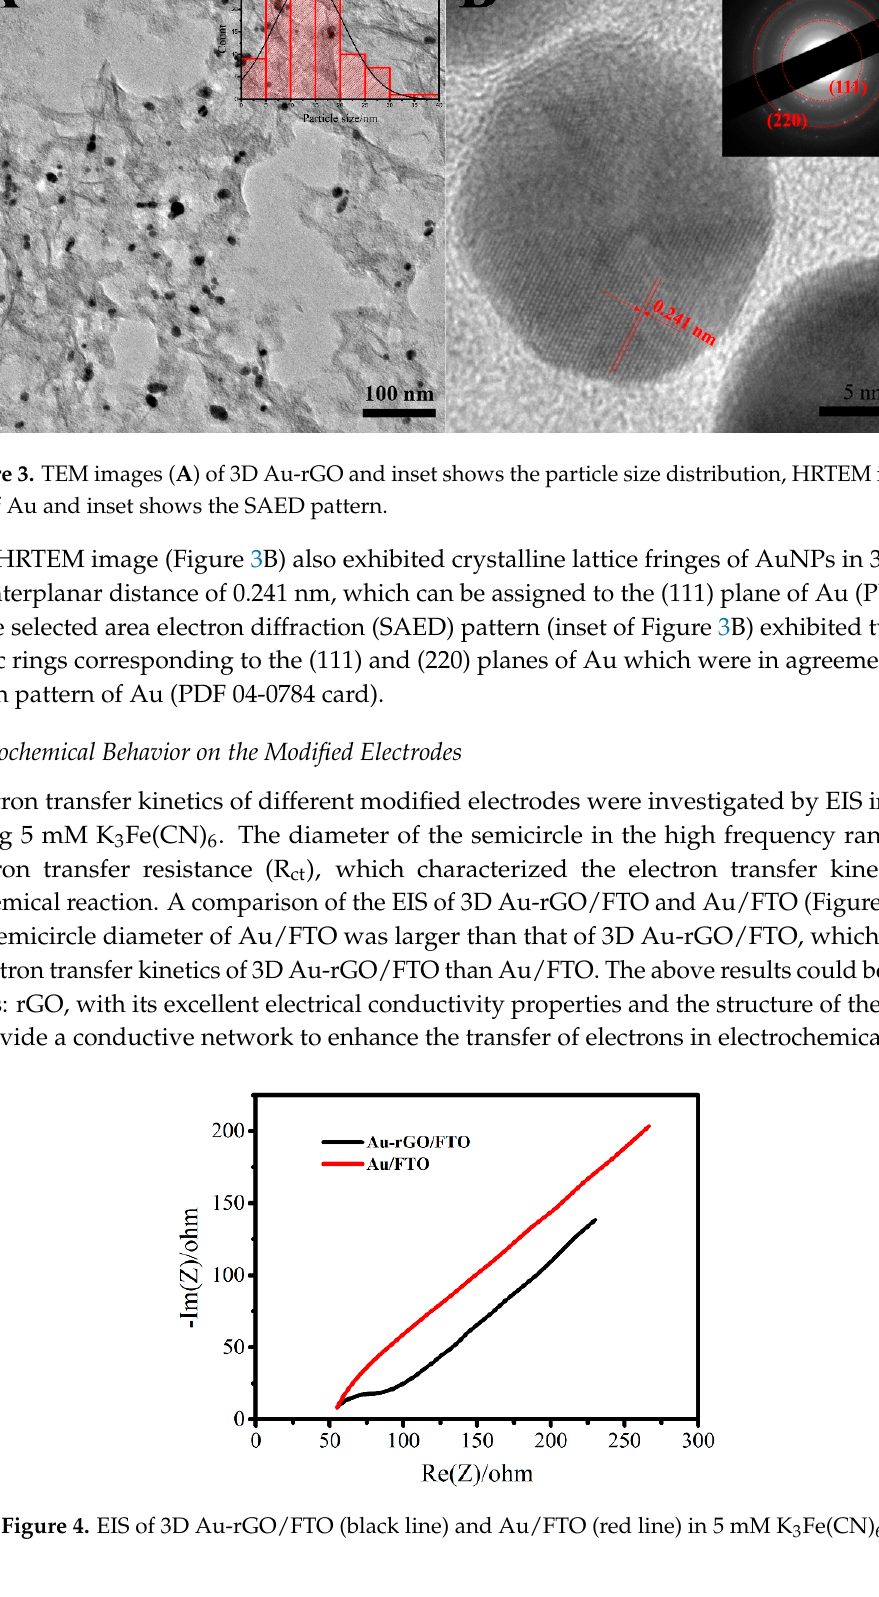
Figure 4. EIS of 3D Au-rGO/FTO (black line) and Au/FTO (red line) in 5 mM K 3 Fe(CN) 6 .